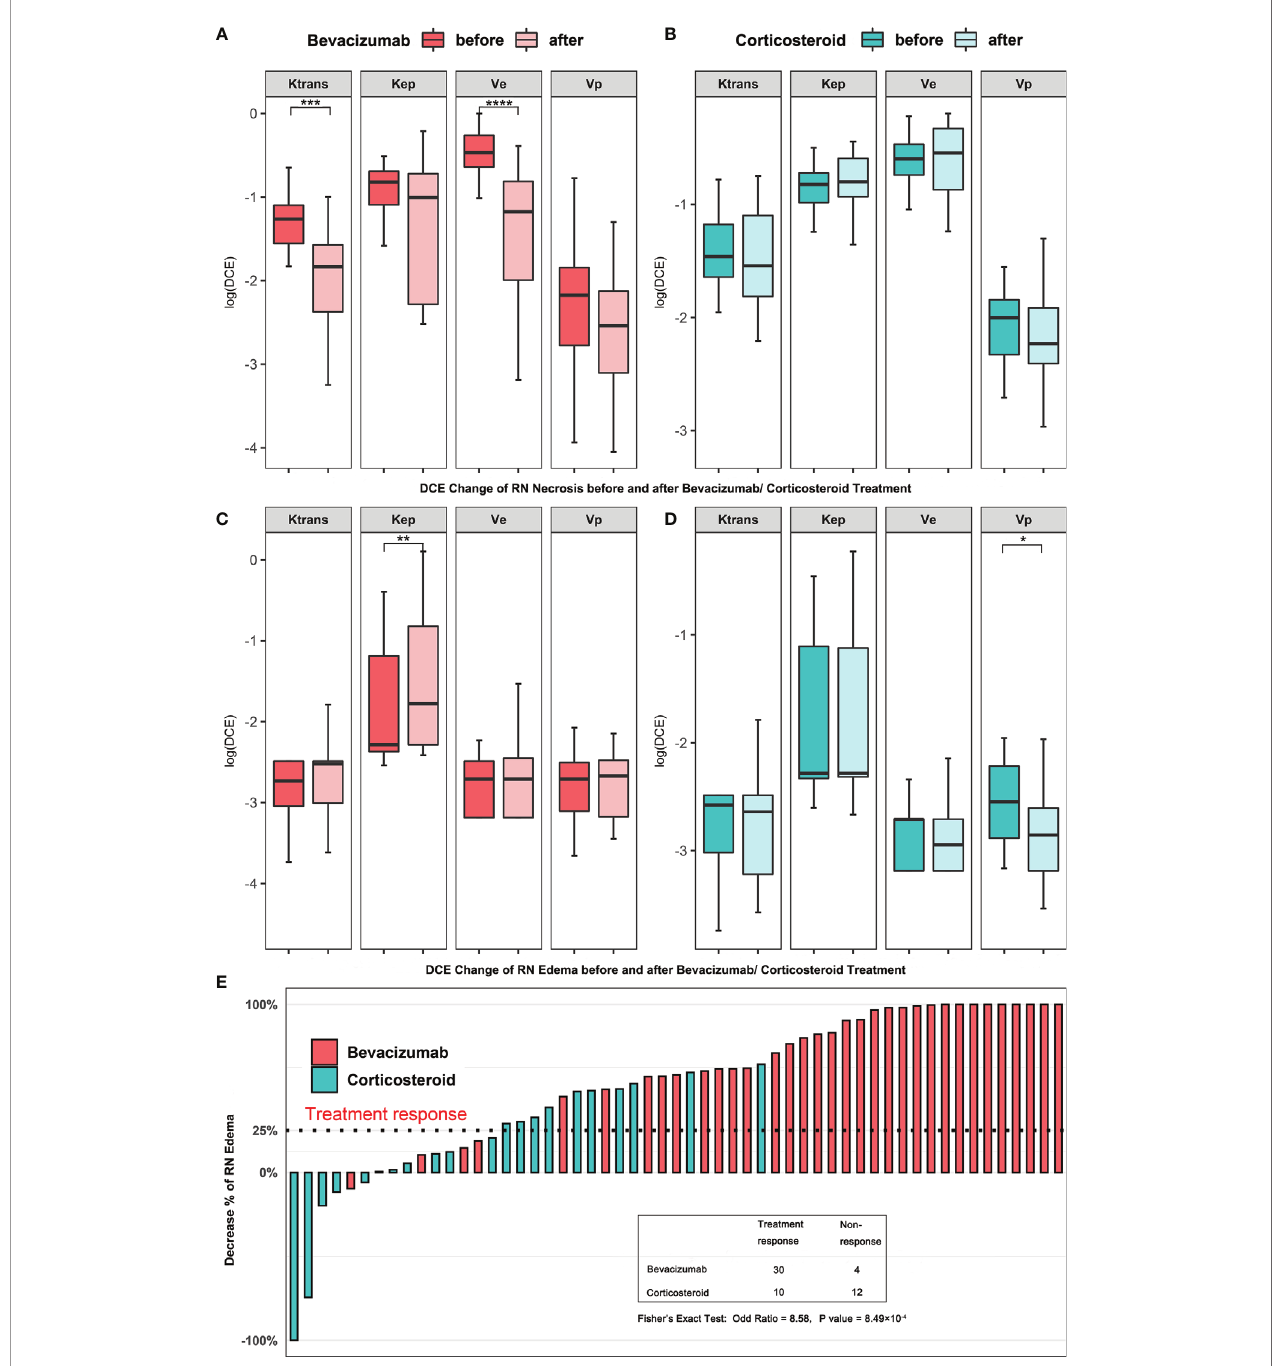
FIGURE 2 | (A – D) Comparison of DCE-derived parameters of RN before and after bevacizumab (A, C) or corticosteroid (B, D) treatment. (E) Treatment response cases in two treatment groups. The straight dash line indicates treatment response. *P value < 0.05, **P value < 0.01, ***P value < 0.001, ****P value <